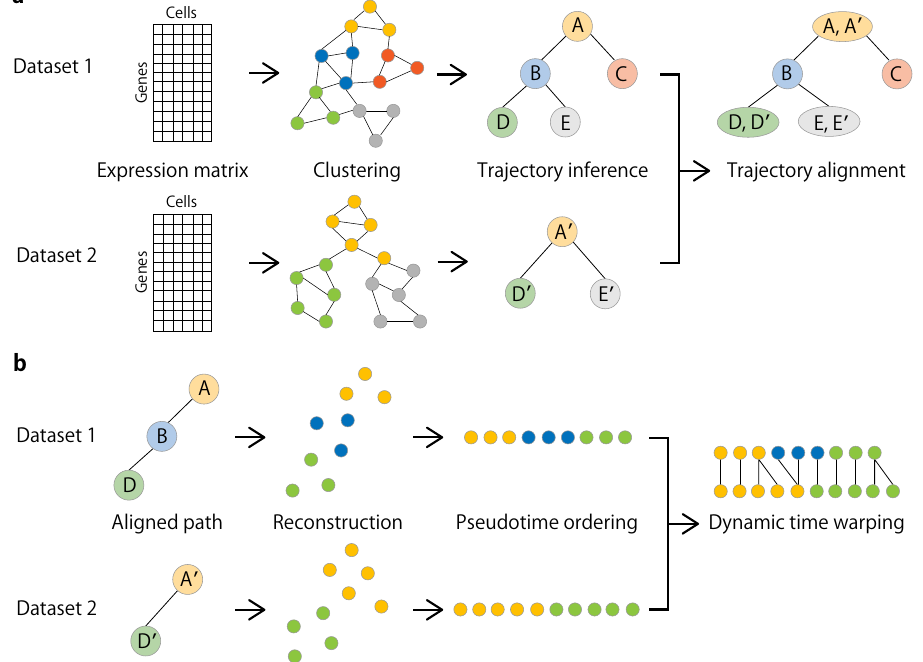
Fig. 1 | Overview of CAPITAL algorithm. a From an expression matrix of each dataset, a nearest neighbor graph is constructed where cells and their expression- basedsimilaritiesarerepresentedasverticesandweightededges,respectively,and then clustered with community detection. Next, a centroid in each cluster is cal- culated to infer a trajectory of clusters by computing the minimum spanning tree. Finally, a tree alignment of trajectories of clusters is obtained by aligning one minimum spanning tree with the other across different datasets on the basis of a